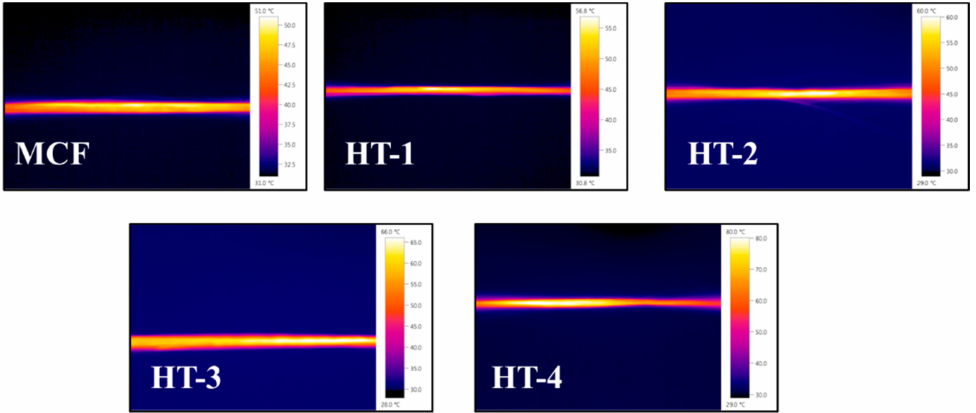
Figure 7. Thermo-graphic camera images of MCF as a function of heat treatment